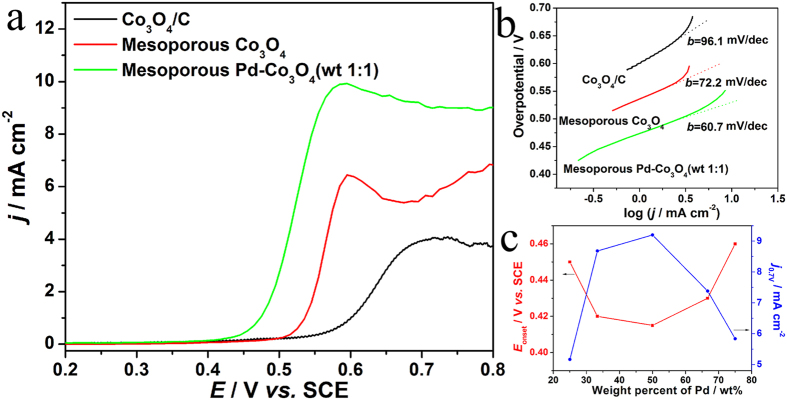
(a) LSV curves in 0.1 mol L−1 KOH with a sweep rate of 0.001 V s−1 on Co3O4/C, mesoporous Co3O4 and Pd-Co3O4 (wt 1:1) electrodes; (b) Tafel plots in 0.1 mol L−1 KOH with a sweep rate of 0.001 V s−1 on Co3O4/C, mesoporous Co3O4 and Pd-Co3O4 (wt 1:1) electrodes; (c) Plots of Eonset and j0.7V in LSV curves as a function of the Au weight percent in mesoporous Pd-Co3O4 with a total loading of 0.1 mg cm−2 on the electrodes.